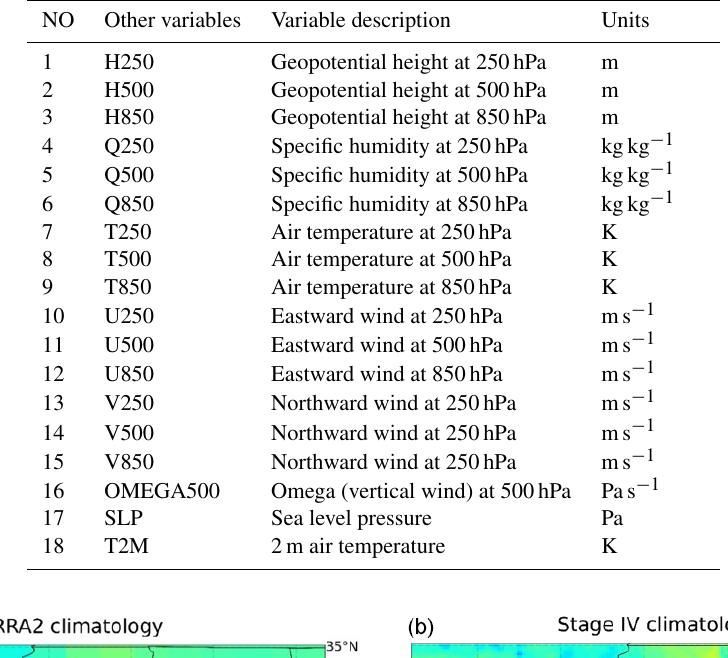
Table 2. Selected atmospheric covariates for DL downscaling and bias correction.